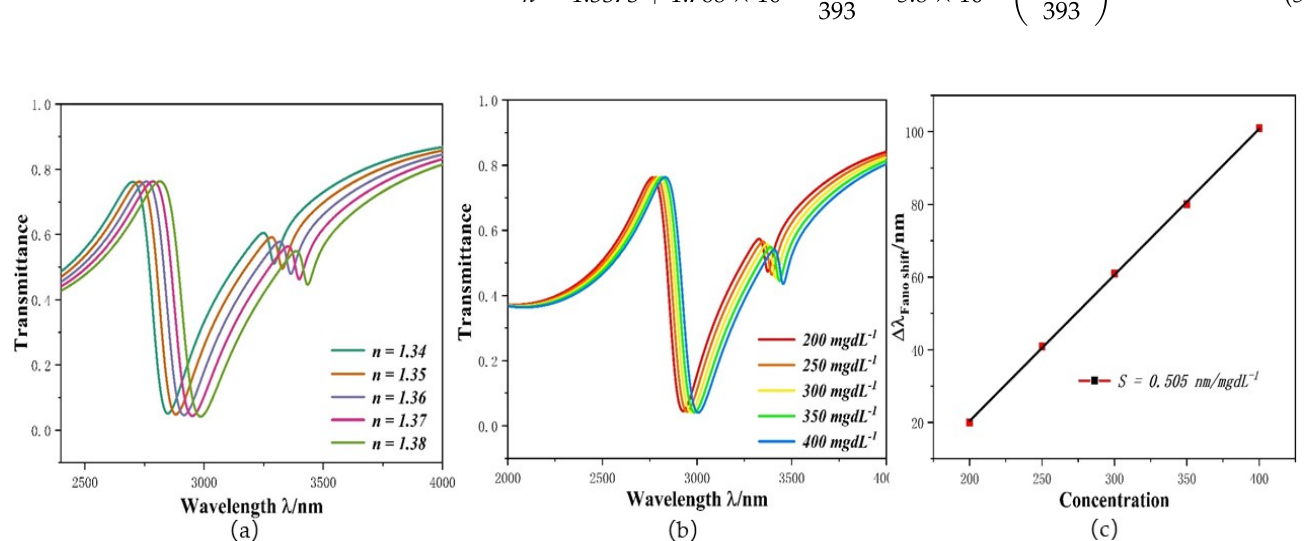
Figure 8. ( a ) Transmission spectra under diverse refractive indexes; ( b ) Transmission spectra under different concentra-tion; ( c ) Sensitivity variation diagram for different concentrations.